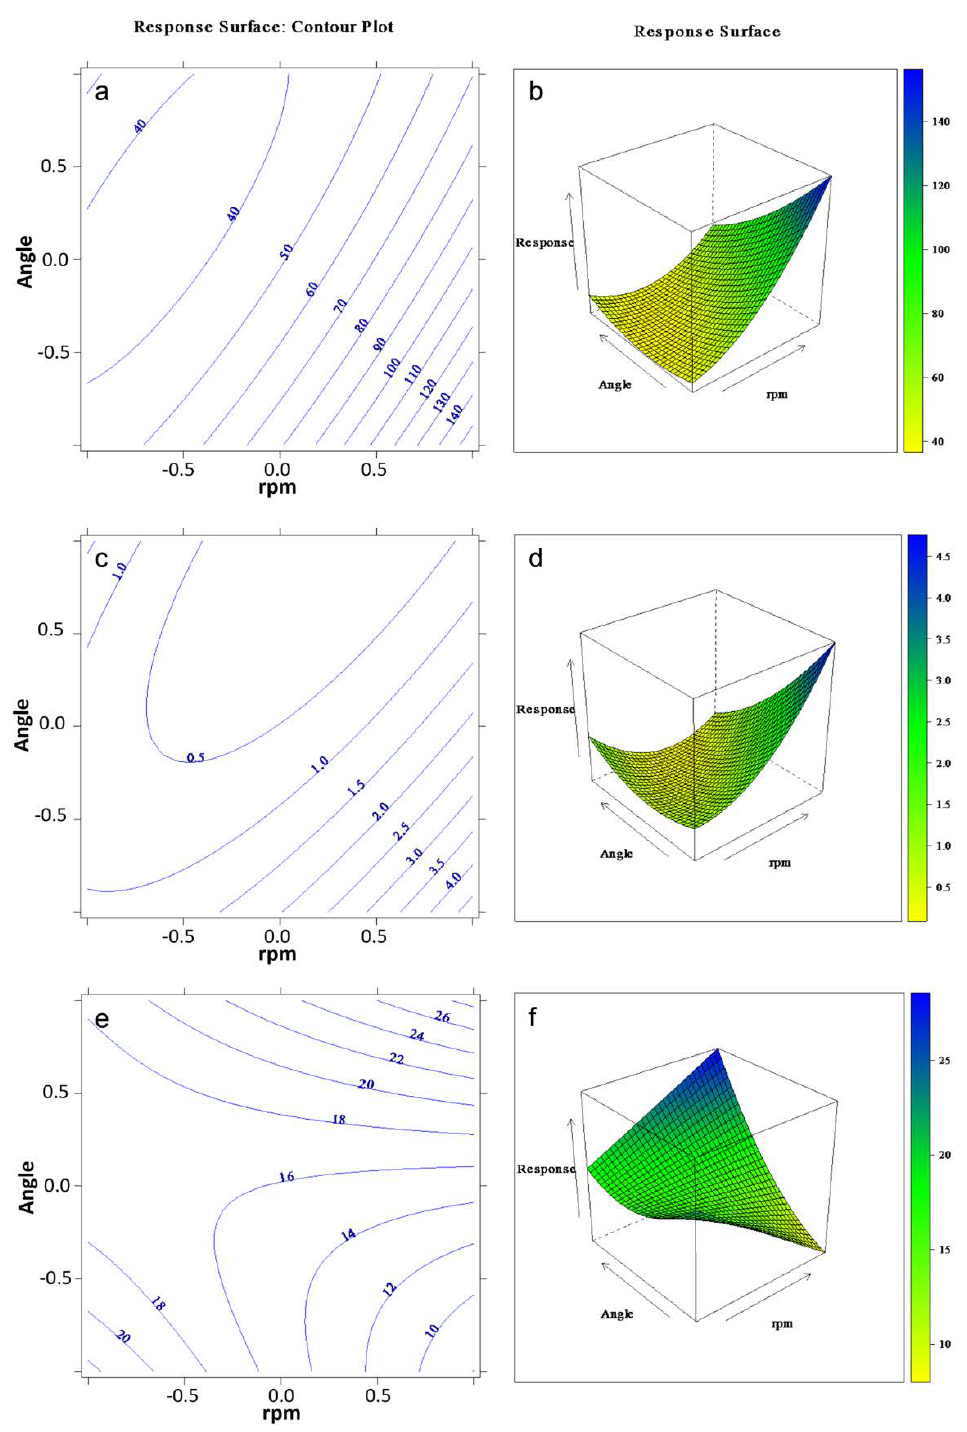
Figure 7. Response surfaces for the Young’s modulus ( a–b ), the maximum tensile strength ( c–d ), and the elongation at break ( e–f